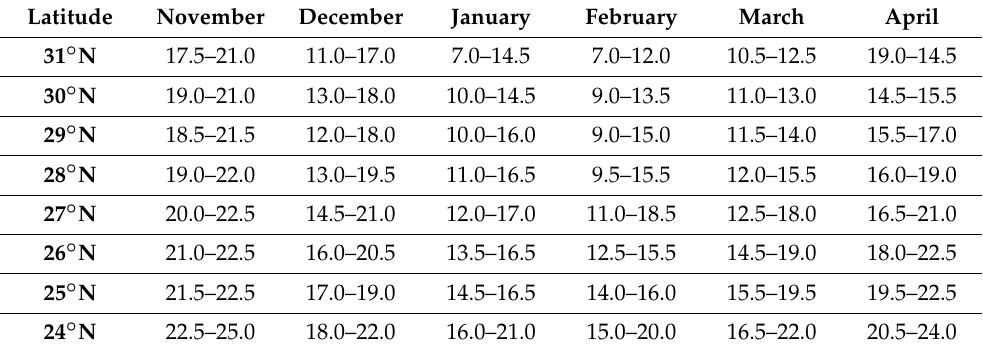
Table 2. Long-term (2016–2020) mean monthly SST across the CCF along 8 parallels (from 31 ◦ N to 24 ◦ N) during cold